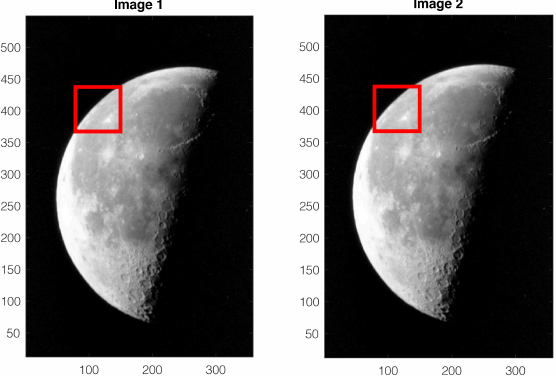
Figure 5. Two images of the moon of 537 × 358 pixels. The template is chosen as the red windows.